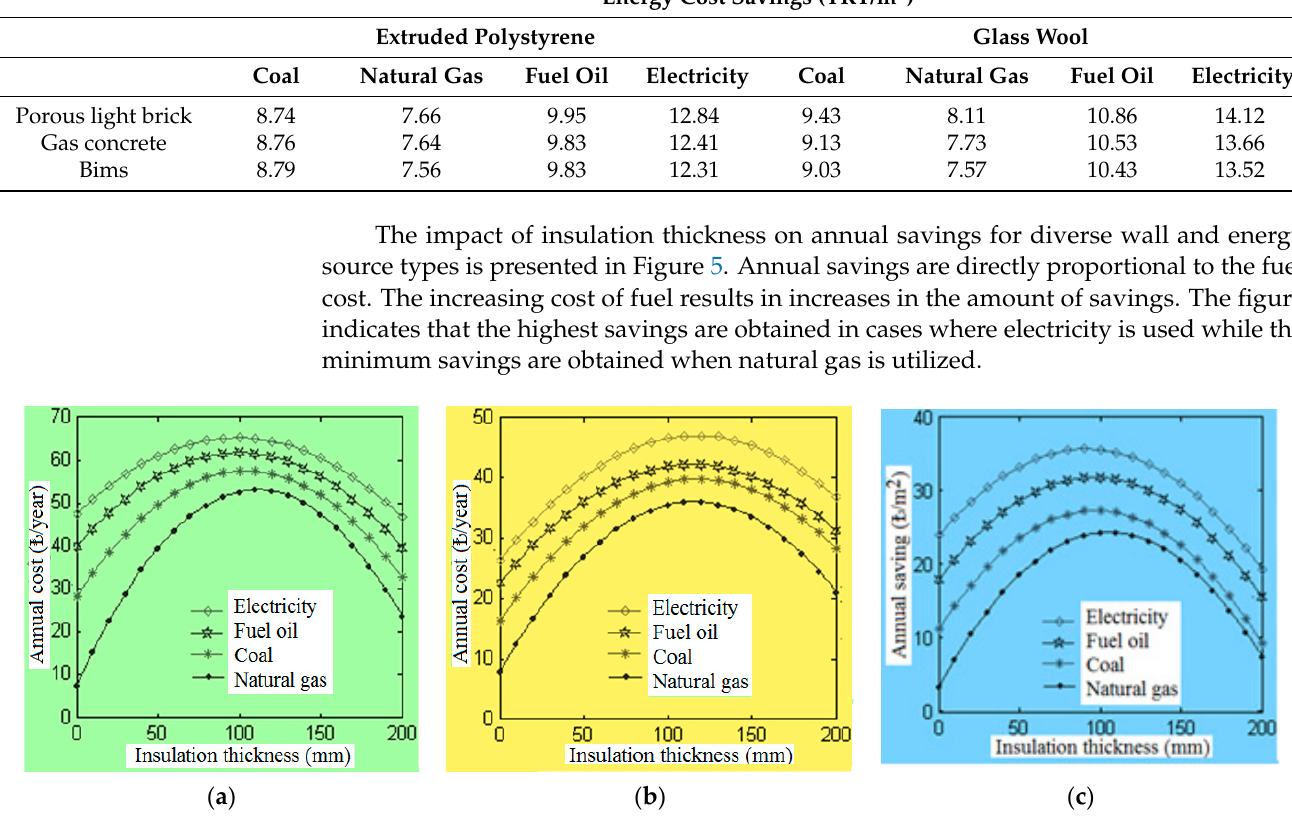
Figure 5. Impact of insulating thickness on annual savings for energy source types (extruded polystyrene insulating material): ( a ) Porous light brick wall; ( b ) Gas concrete wall; ( c ) Bims wall.